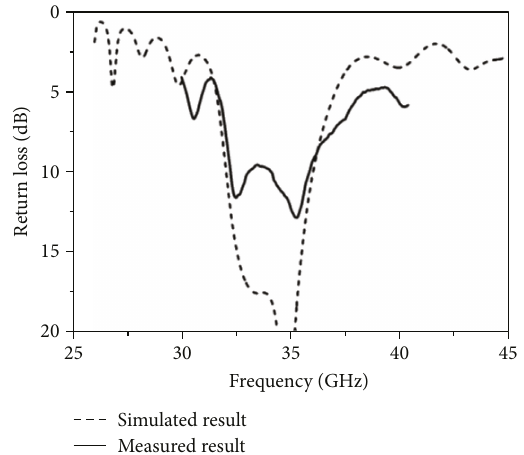
Figure 6: Simulated and measured return loss of the proposed